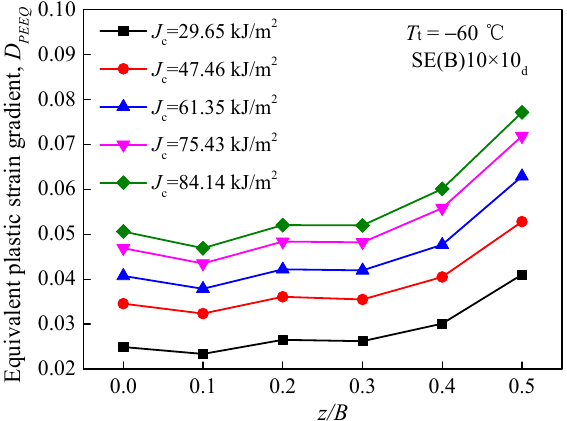
Figure 6. Equivalent plastic strain gradients around crack fronts.